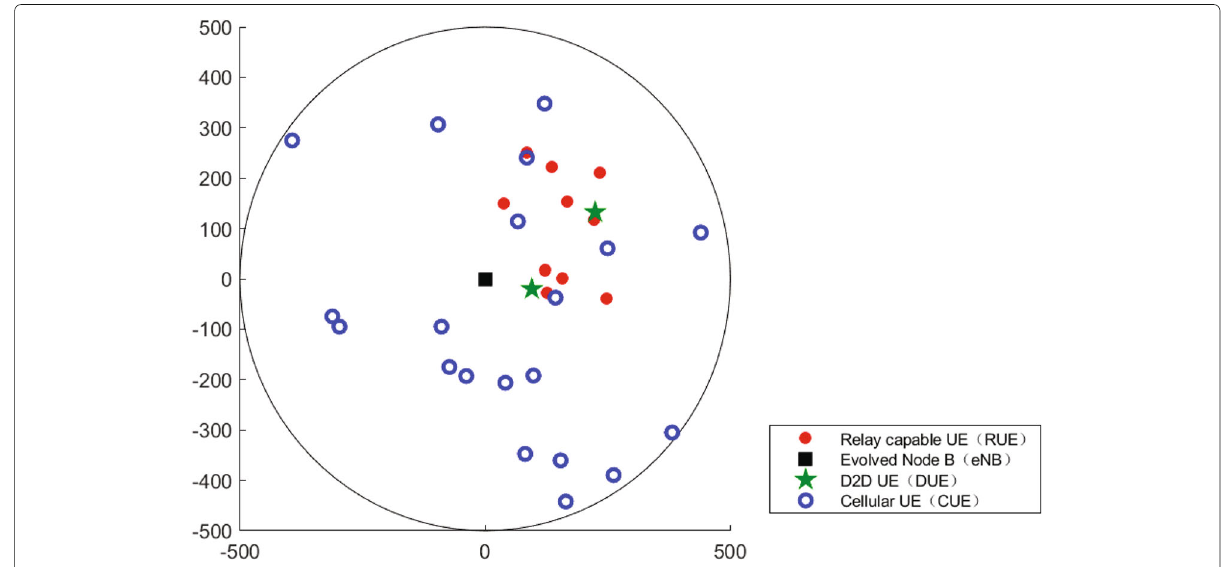
Fig. 5 The distribution of the users in the cell